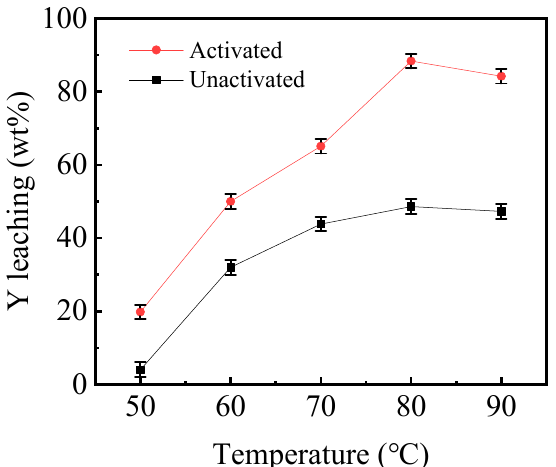
Figure 6. The effect of reaction temperature on leaching efficiency before and after mechanical activation (t MA = 60 min t L = 12 h).